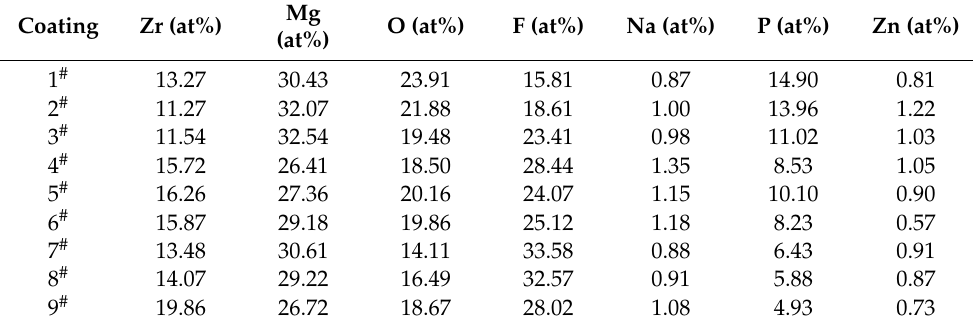
Table 3. EDS analysis of the coating surface (1 # – 9 # ) prepared in different parameters.